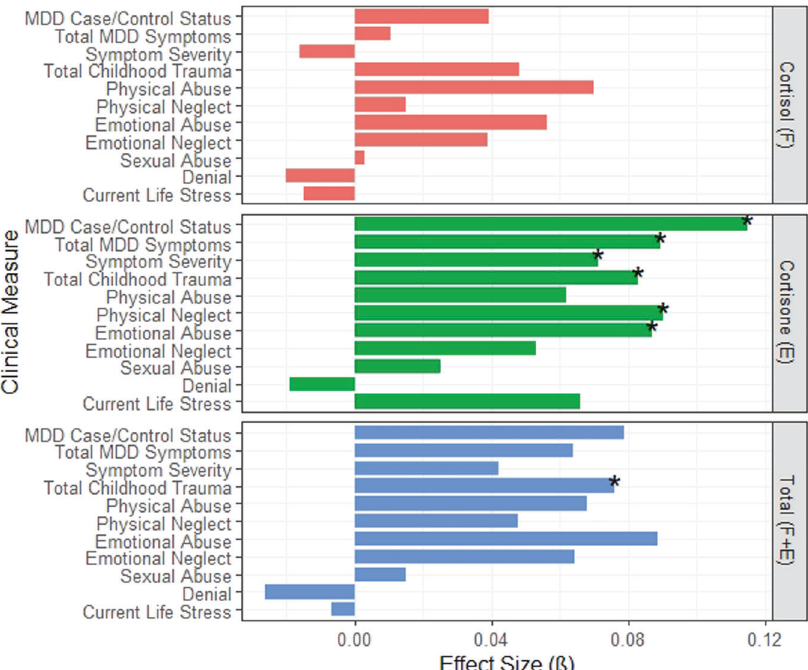
Fig. 1 Standardised effect sizes ( ß ) of hair cortisol (F), cortisone (E) and total glucocorticoid associations (F + E) with depression and stress measures. MDD case/control Status is determined through SCID diagnosis. MDD symptom totals are total QIDS scores and the severity is also determined by QIDS scores. Trauma scores are determined from CTQ scores and current life stress is measured from LTE scores. Associations where P < 0.05 are marked with an